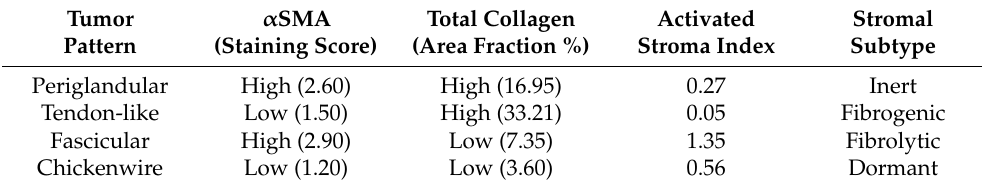
Table 3. Activated stroma index in the four tumor patterns. The index is the ratio between α SMA expression (immunohistochemically assessed) and the total amount of collagen (morphometric evaluation), averaged for each pattern. Assignment to the stromal subtypes is according to [104]. Kruskal-Wallis testing showed significant difference in activated stroma index between the four patterns ( p < 0.01). α SMA, α -smooth muscle